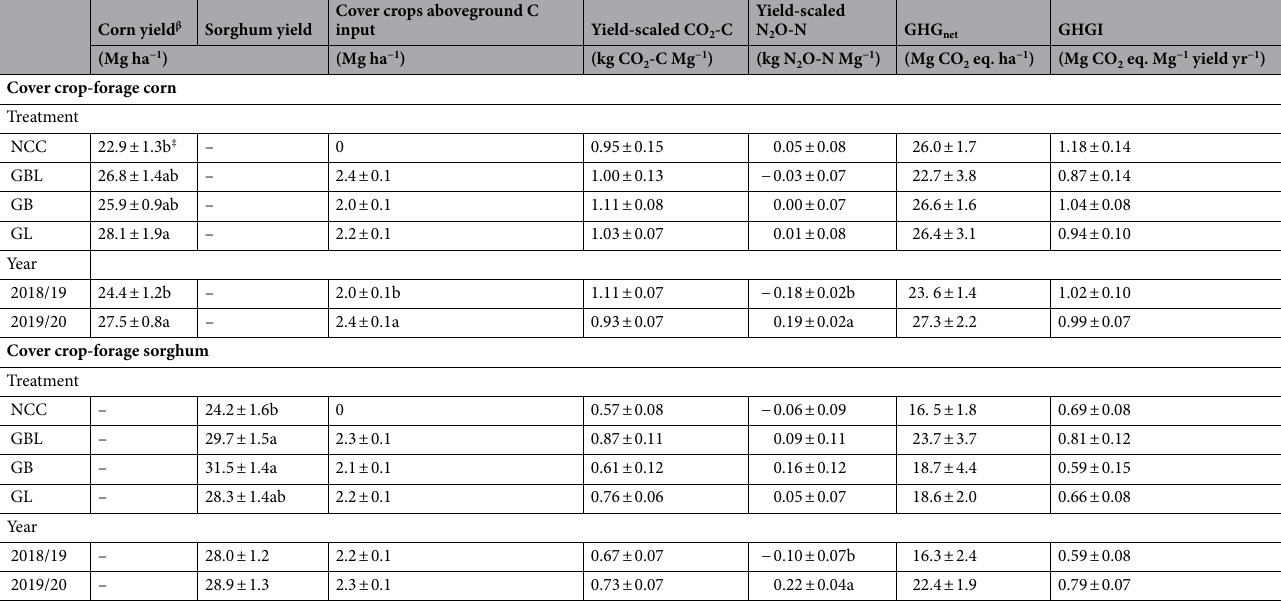
Table 3. Crop yield, carbon input, net greenhouse gas balance (GHG net ), yield-scaled CO 2 -C and N 2 O-N emissions, and greenhouse gas intensity (GHGI) in cover crop integrated forage corn and forage